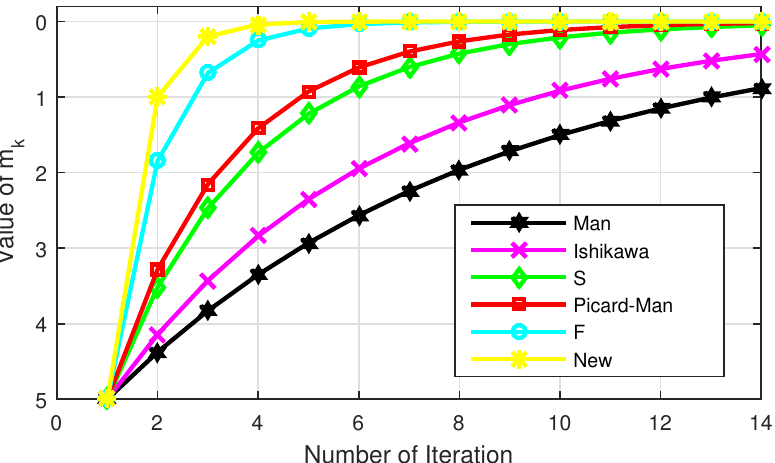
Figure 3. Graph corresponding to Table